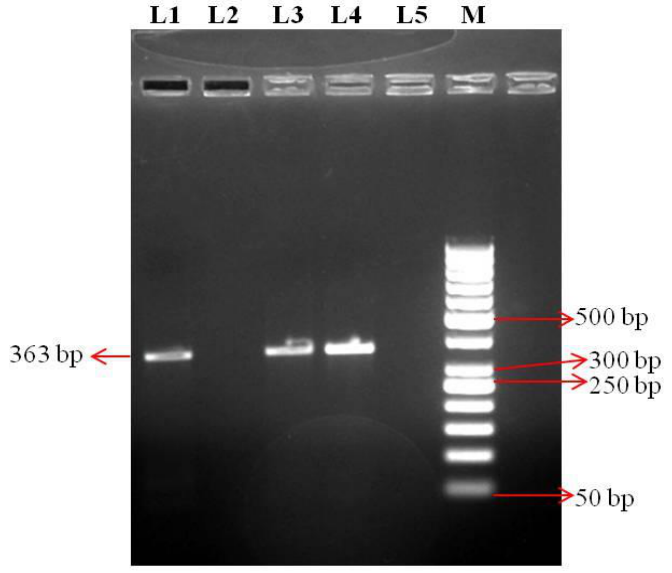
Figure 1. Confirmation of the Newcastle disease virus (NDV) isolates through PCR. PCR carried out with F gene specific primers. Lane 3 and Lane 4 show 363 bp F gene amplification product of duck NDV isolate (As/Km/19/44) and parrot NDV isolate (As/WB/19/91), respectively; Lane 1, positive control (ND LaSota vaccine); Lane 2, negative control and Marker (M), a 50 bp DNA ladder (Thermo Scientific, Waltham, MA,